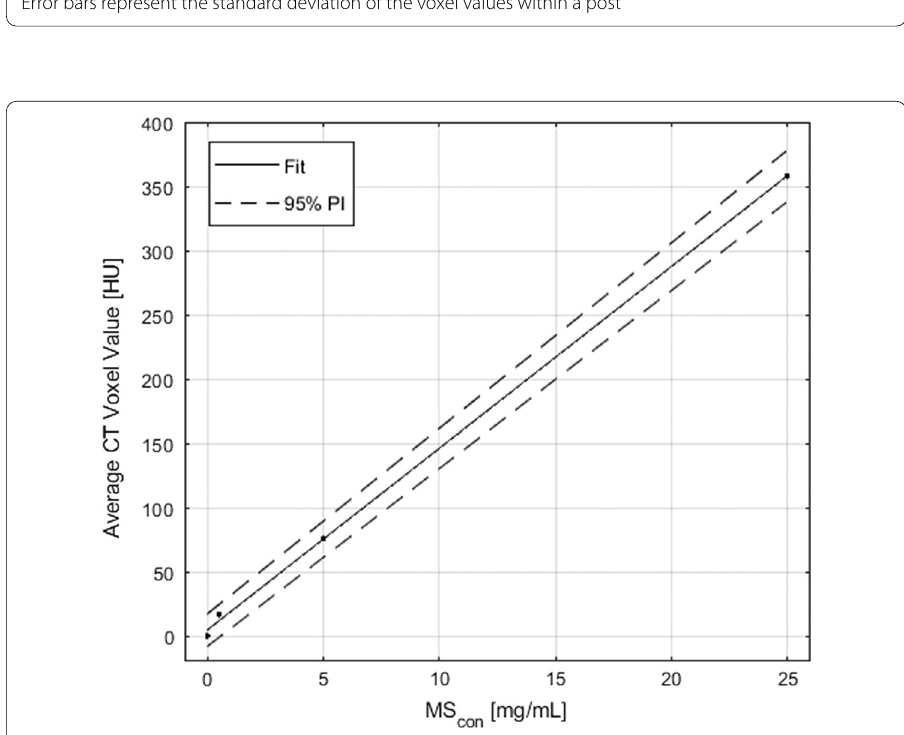
Fig. 4 A calibration curve derived from the analysis of the calibration phantom. The coefficient of determination is r 2 0.999. Voxel values were extracted for the 15 mm-diameter posts ≥